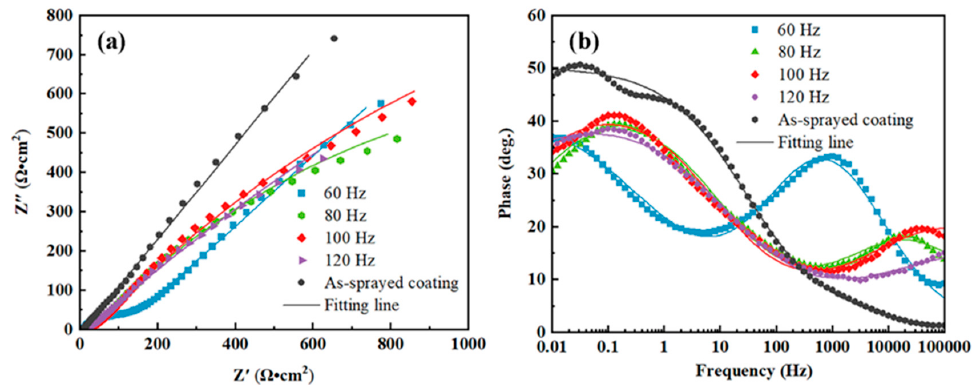
Figure 9. Electrochemical impedance spectra of the metallic glass coating samples in 3.5 wt.% NaCl solution: ( a ) Nyquist and ( b ) Bode plots.